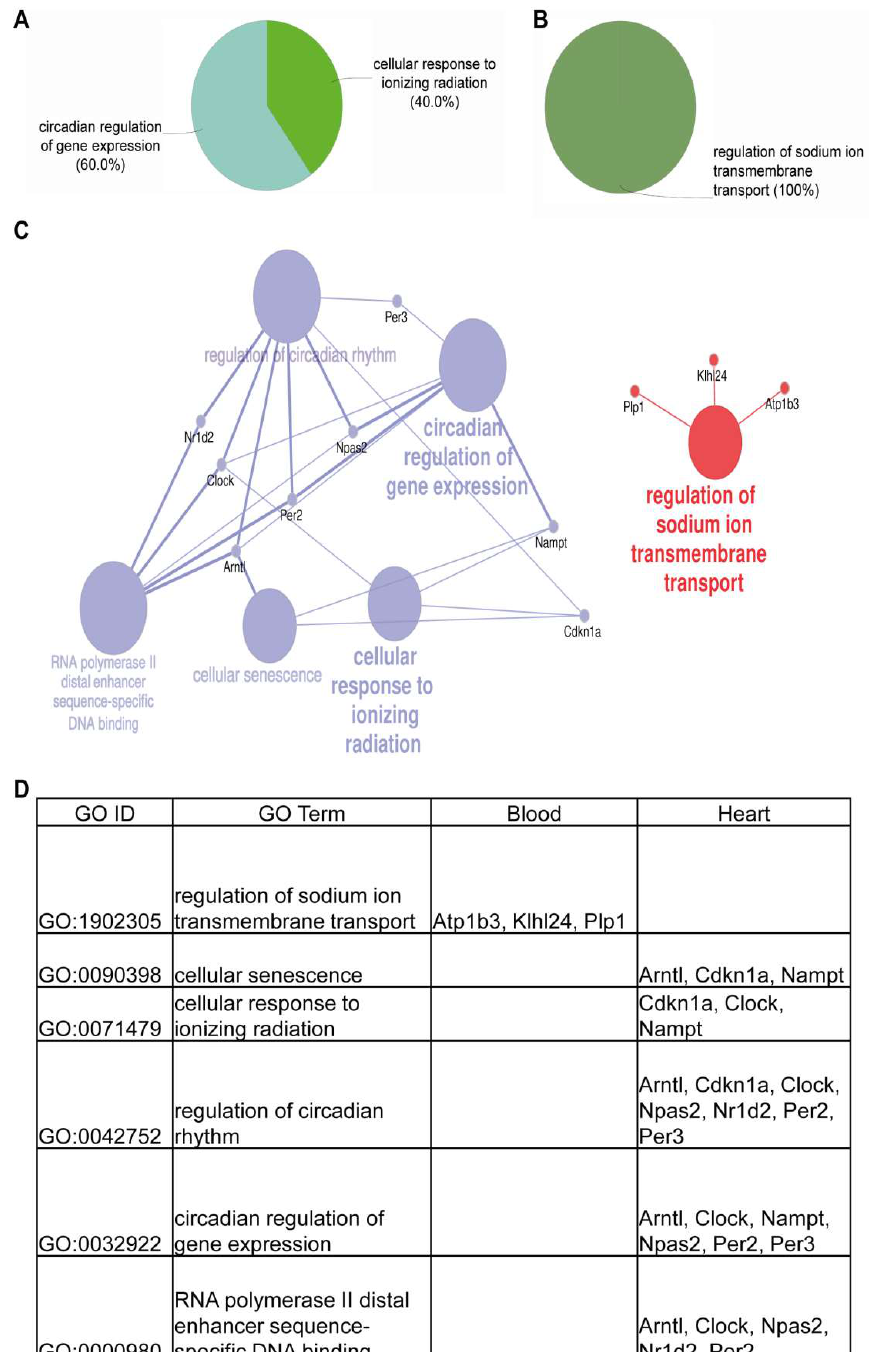
Figure 6. Gene Ontology (GO) enrichment and network analysis reveals the pathways influenced by cardiomyocyte transplantation. GO enrichment analysis expressed as % terms per group was performed on differentially expressed (DE) targets in the heart ( A ) and blood ( B ). ( C ) Network analysis using the GO terms of these targets. In the network, the transcripts from the heart and the corresponding GO terms are represented in blue circles with the transcripts from the blood and their corresponding GO terms being represented in red circles. ( D ) The respective GO ID and GO terms of these DE targets in the heart and blood.